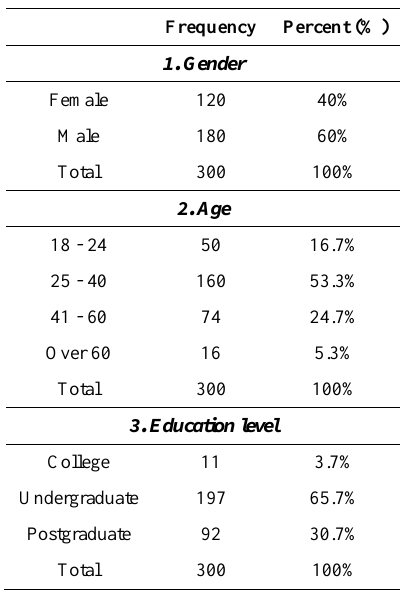
Table 2. Characteristics of respondents